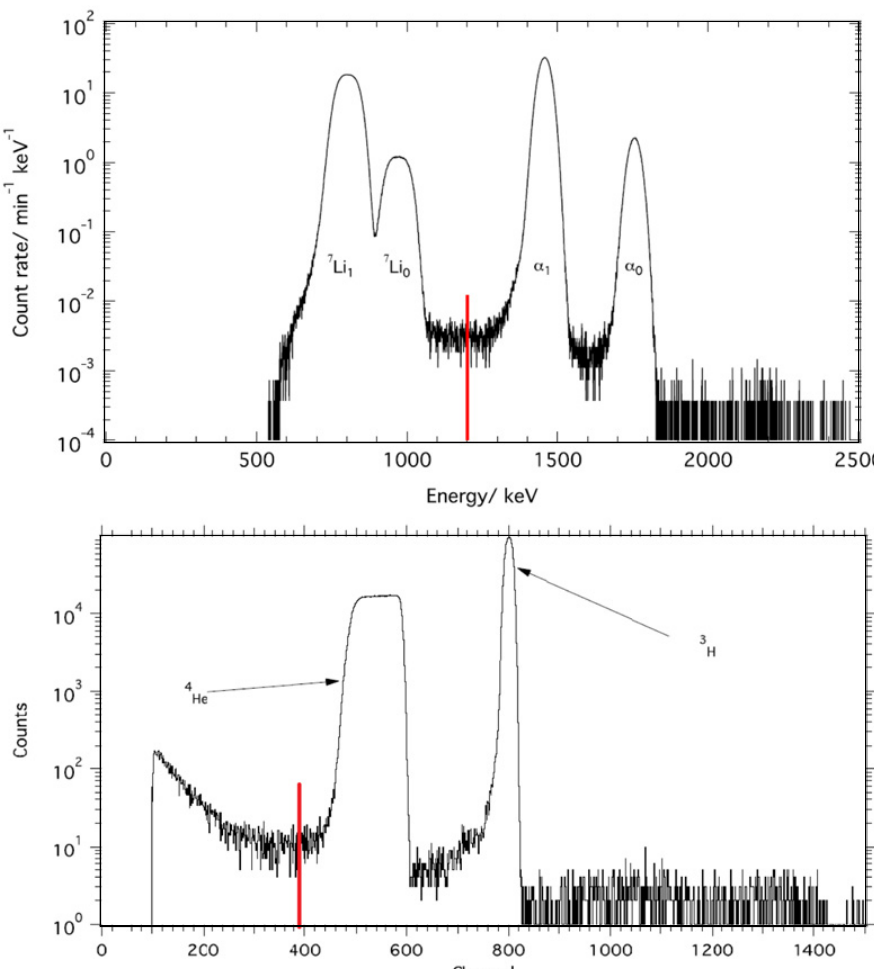
Figure 3. Spectra from the Alpha-Gamma α detector (top) and flux monitor α detectors (bottom). A red line indicates the lower SCA threshold in each spectrum.